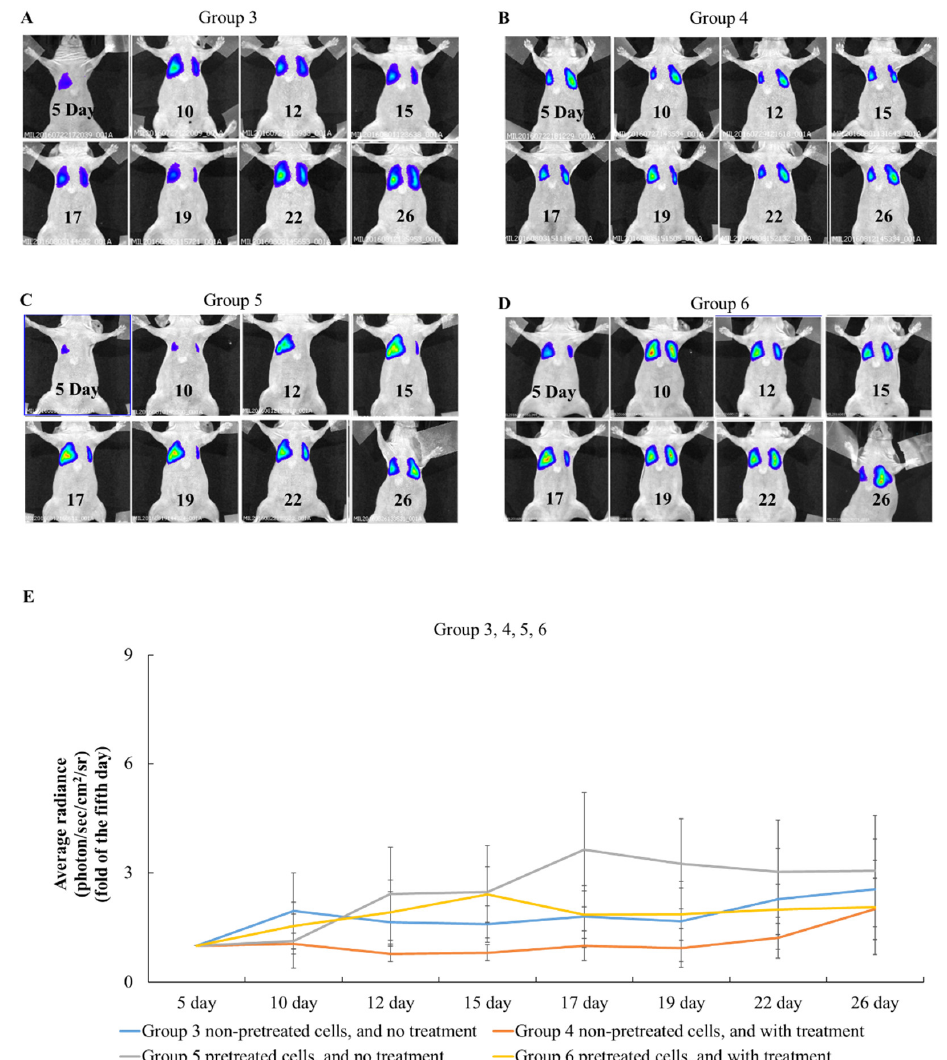
Figure 4. Bioluminescent images in the BxPC-3 cell intravenously induced pancreatic cancer mice ( B ) Group 4: Intravenous non-pre-treated cells that were treated with simvastatin after